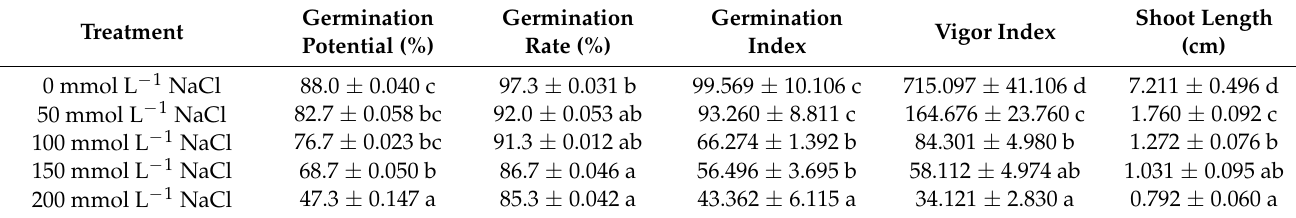
Table 1. Effects of different NaCl concentrations on germination parameters of F. tataricum seeds.